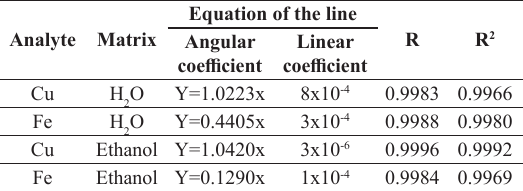
Table 3. Linearity data obtained by least squares regression.